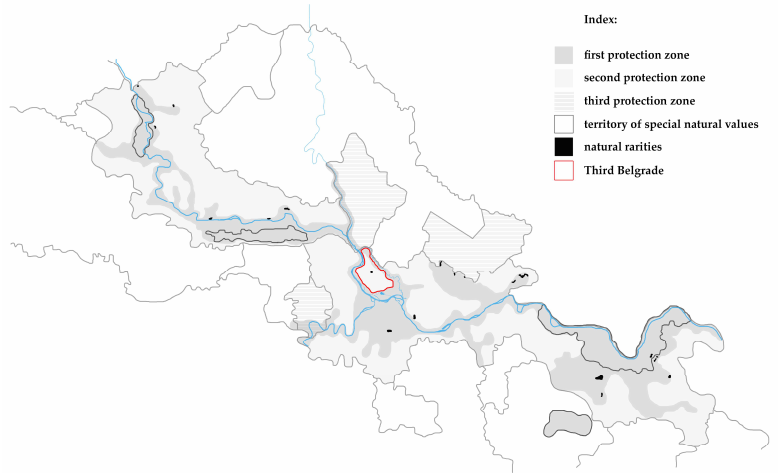
Figure 6. Regional Spatial Plan for Tourism Development on the Danube—Projected condition of green areas, 1968—Insight into the position of the PKB territory in the wider tourist-ecological system. Source: Authors drawing based on [65].